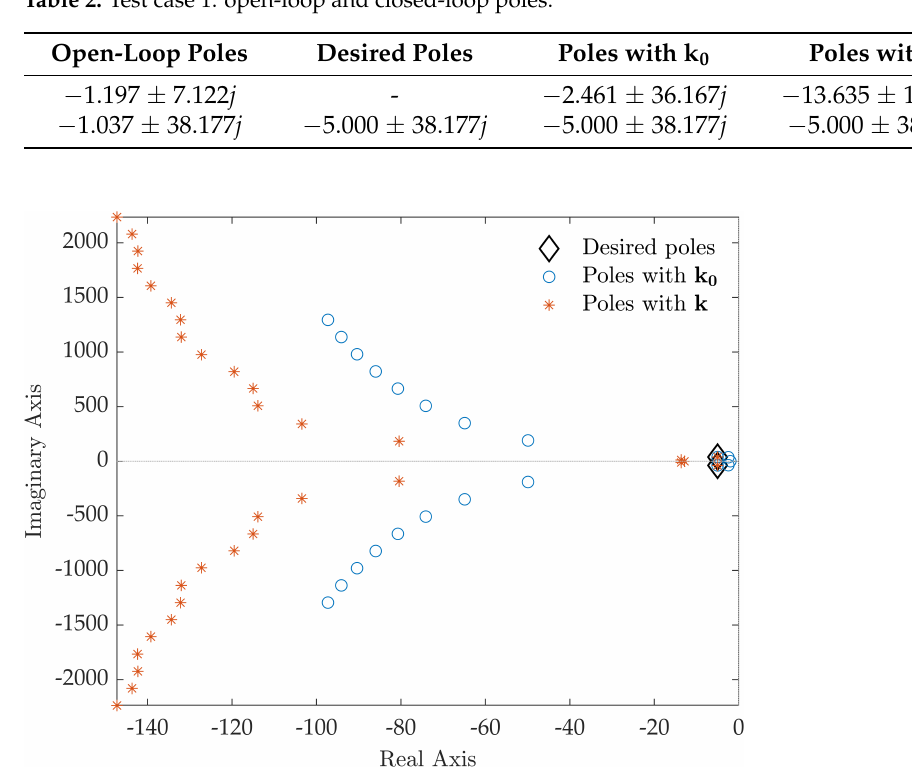
Figure 3. Test case 1: closed-loop poles.